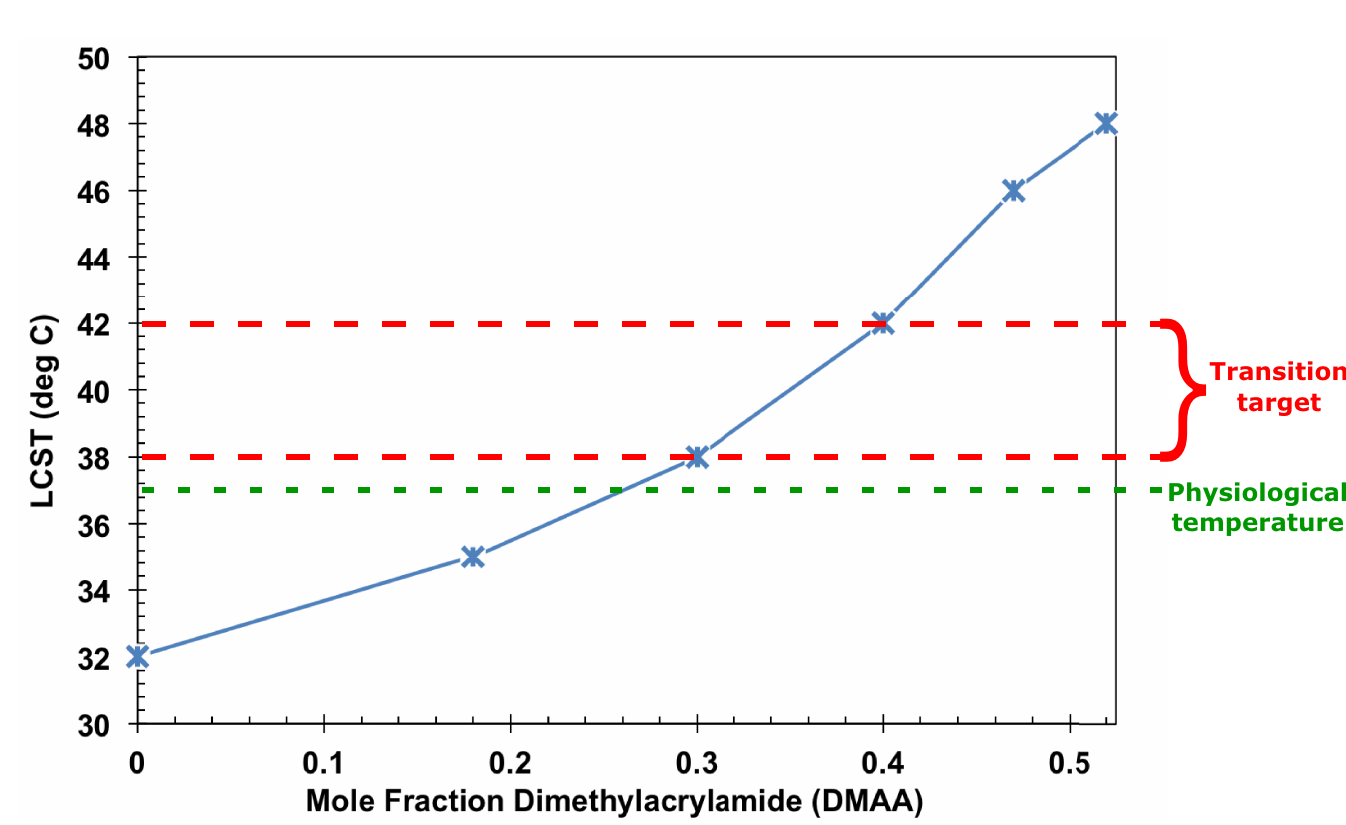
Fig 3. Dimethylacrylamide (DMAA)-dependence of the lower critical solution temperature (LCST) of the copolymer. Datapoints are based on visual determination of solution steady-state opalescence at fixed temperatures. A data connecting line is provided for trend visualization.